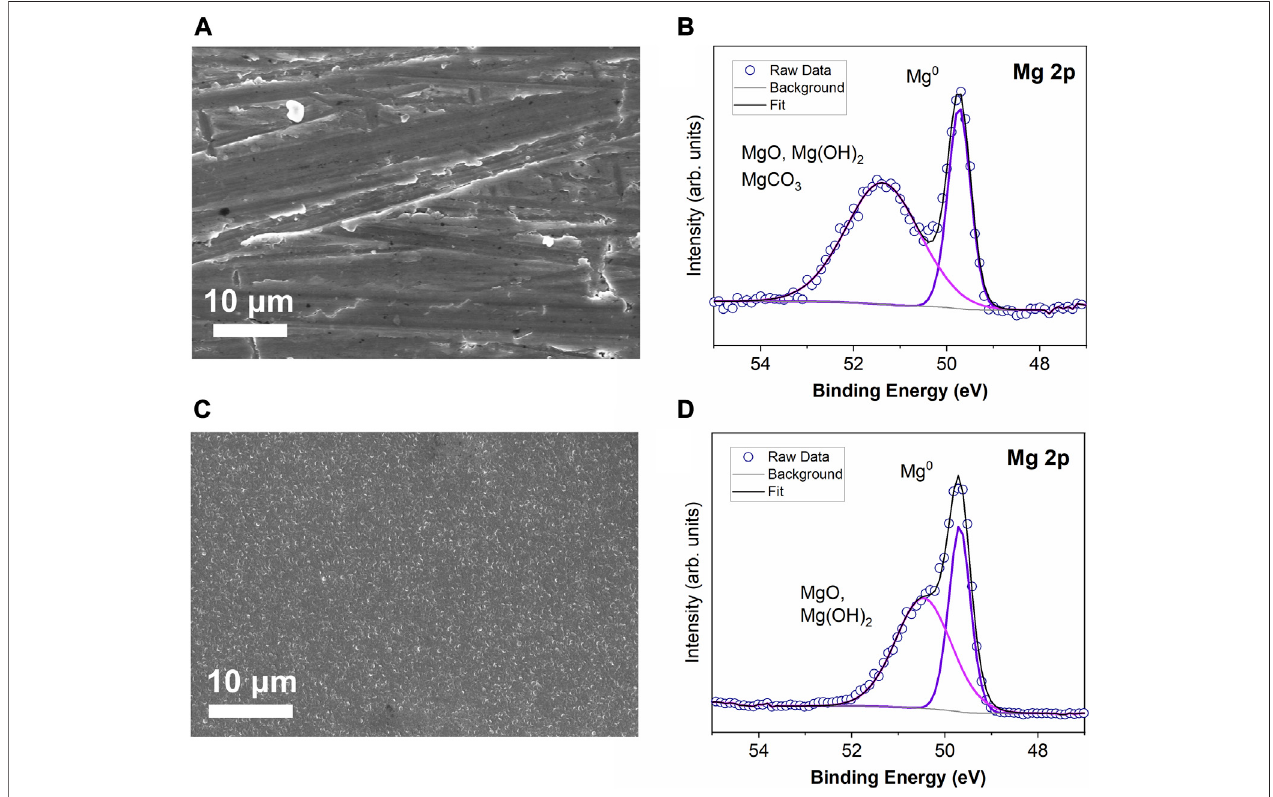
FIGURE 1 | Comparison of SEM images and XPS high resolution spectra for (A) and (B) polished Mg foil substrates and (C) and (D) evaporated Mg metal on stainless steel.